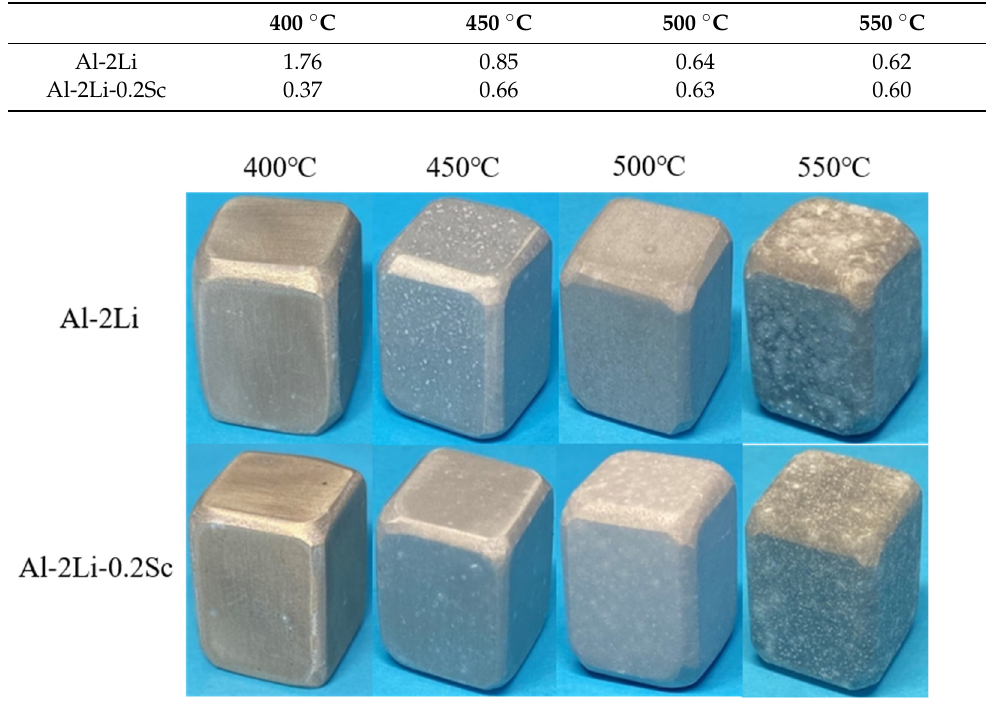
Table 2. The oxidation reactivity indexes of Al–2Li and Al–2Li–0.2Sc alloys at different exposure temperatures.